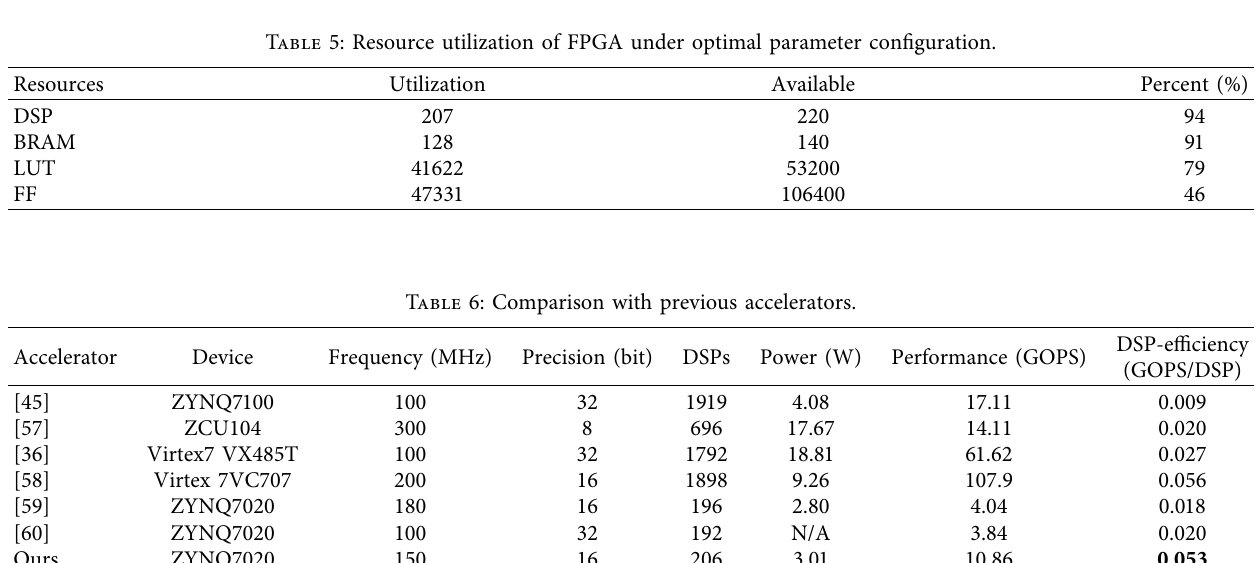
Figure 8: Resource utilization and computing performance of diferent parallelism confgurations. Parallelism factor N ∈ N is the computational parallelism of standard convolution, N where N 1 putational parallelism of DWC.